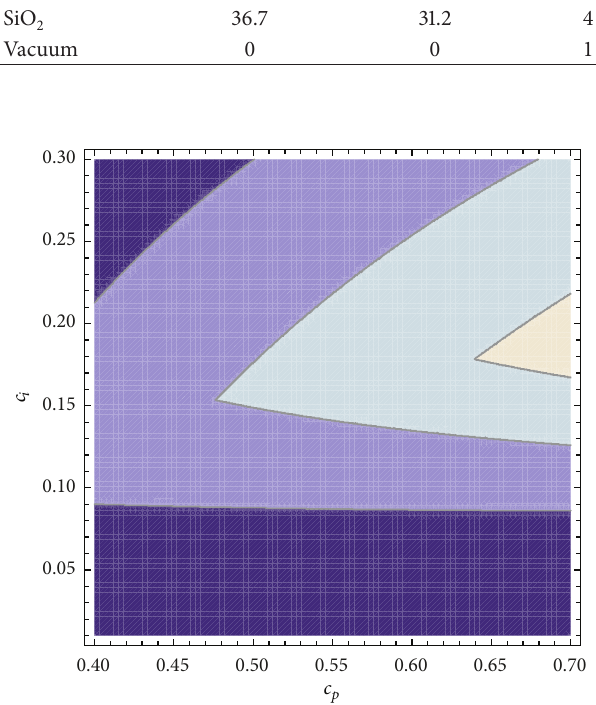
Figure 12: Effective property map for porous Parylene coated with SiO 2 versus volume fractions 𝑐 𝑝 and 𝑐 𝑐 of pores and coating layer, respectively. Properties of the components are given in Table 2. Regions with 𝑘 ∗ < 1.5 , 𝐸 ∗ > 5 GPa (yellow), 𝑘 ∗ < 1.6 , 𝐸 ∗ > 4 GPa (light blue), 𝑘 ∗ < 1.7 , 𝐸 ∗ > 3 GPa (blue), and 𝑘 ∗ ≥ 1.7 , 𝐸 ∗ ≤ 3 GPa (dark blue).